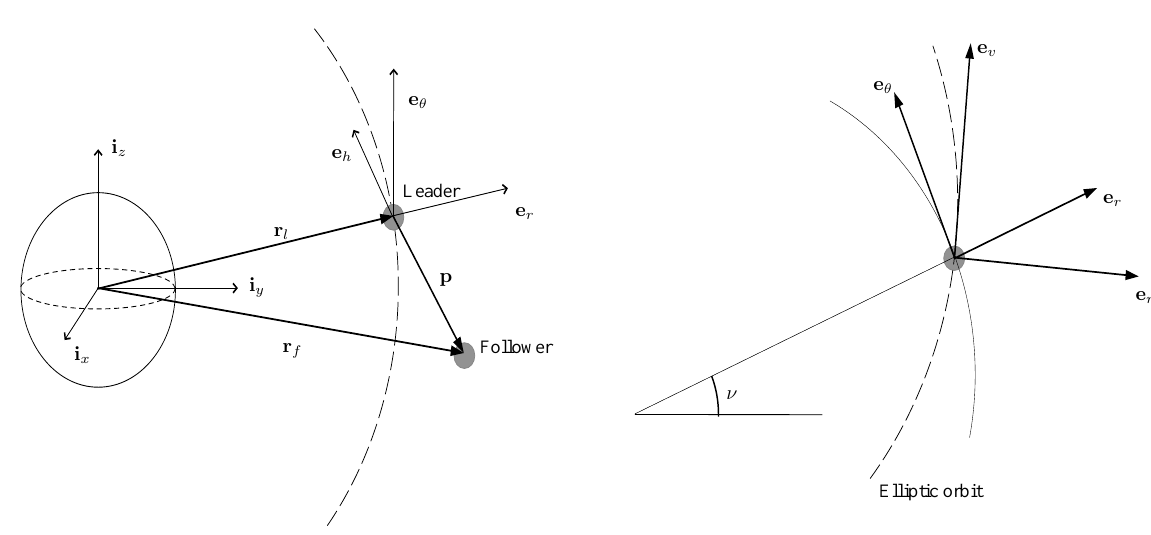
Figure 1: Reference coordinate frames (Schaub and Junk- ins, 2003).